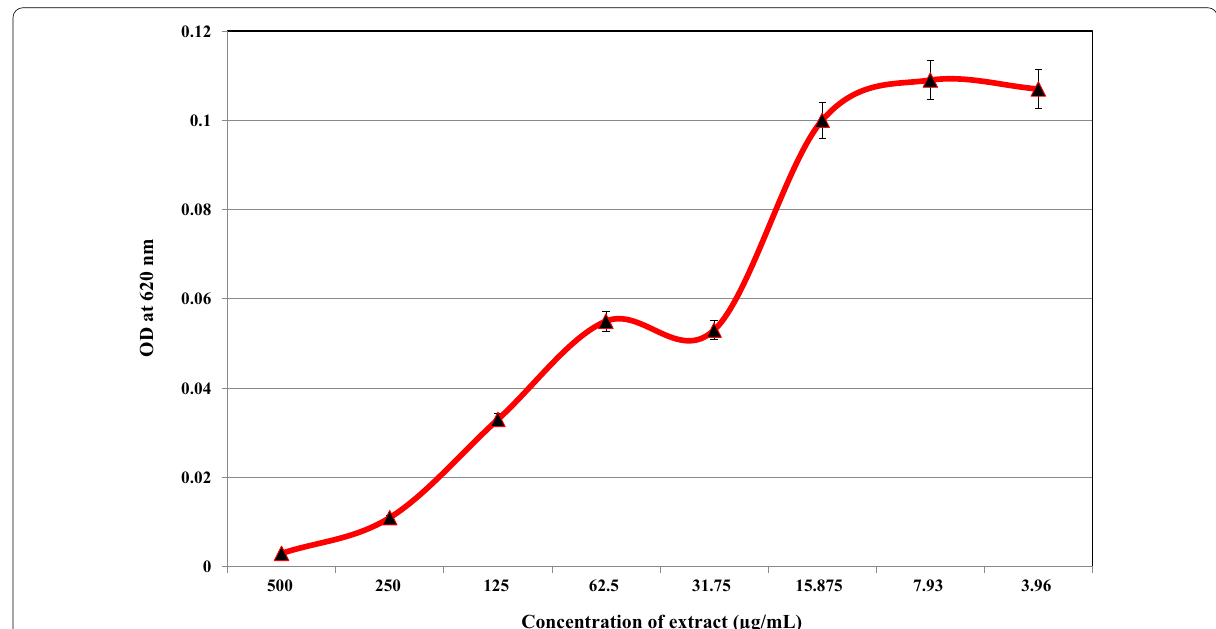
Fig. 2 Minimum inhibitory concentration (MIC) of the plant extract fraction was observed to be 15.7